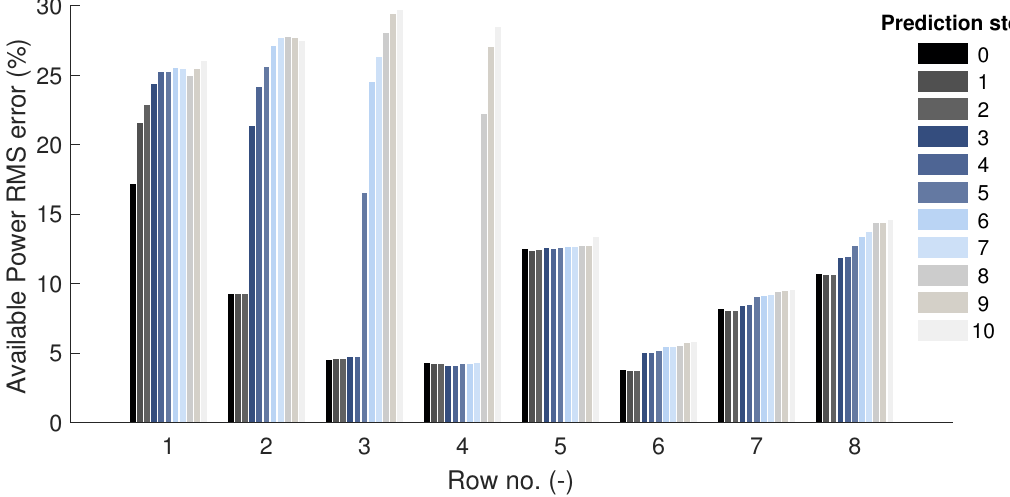
Figure 13. Accuracy of 10-step ahead prediction of turbine available power for each row of large-scale wind farm. Accuracy is normalized RMS difference between DFP prediction and SWF averaged over turbine rows. Kalman filter in DFP is